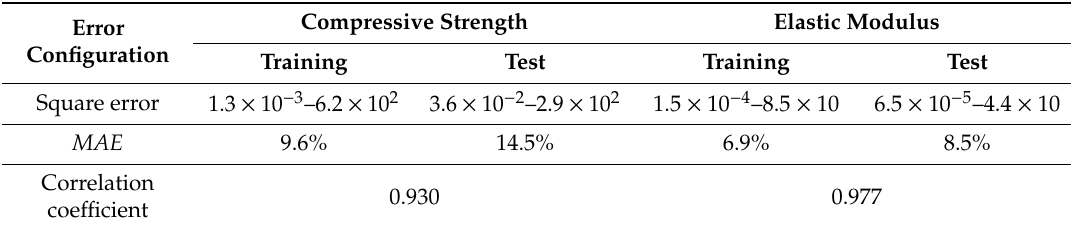
Table 5. Prediction accuracy of ANN-based